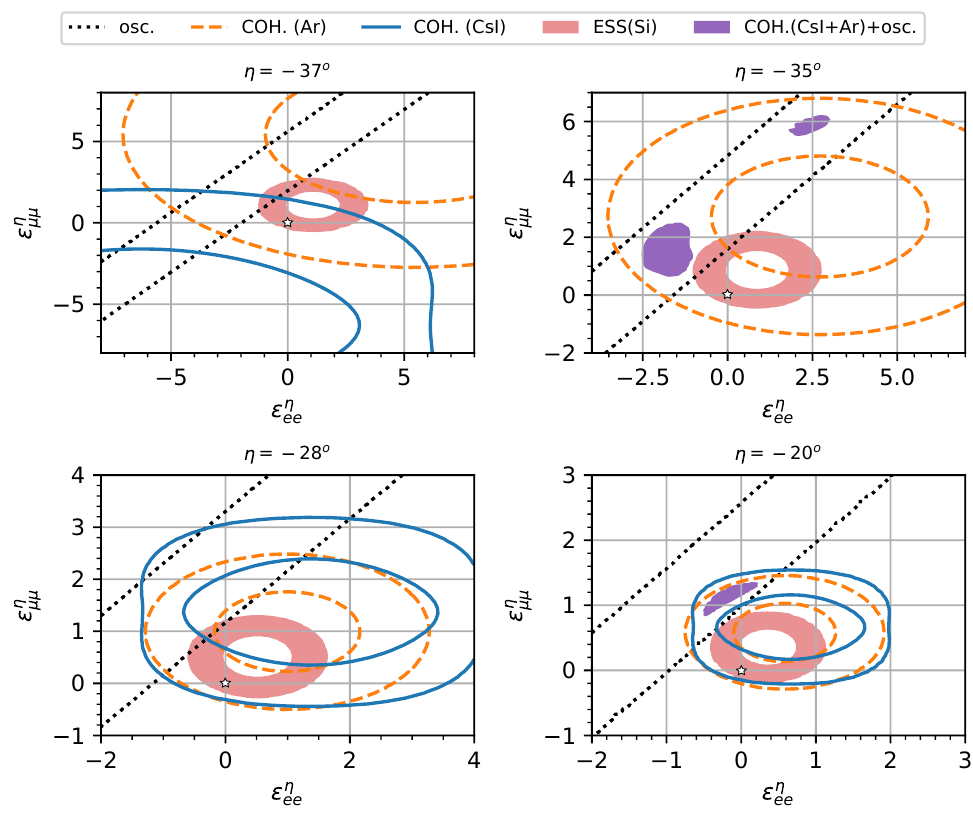
Figure 2 . Allowed regions in the plane of (cid:15) η and (cid:15) η at ∆ χ 2 = 11 . 83 corresponding to 3 σ for ee µµ 2 dof, for different fixed values of η . The contour lines correspond to the regions from oscillation data, Coh (CsI), and Coh (Ar) separately. The purple filled region is obtained by combining all three data sets. The diagonal band corresponding to oscillation data does not pass through the SM point (cid:15) η = (cid:15) η = 0 because we have assumed the LMA-dark solution with θ 12 > 45 ◦ . The light-red µµ ee filled region shows the sensitivity of a future measurement at ESS using a Si detector, assuming the SM. Off-diagonal (cid:15) η are fixed at αβ